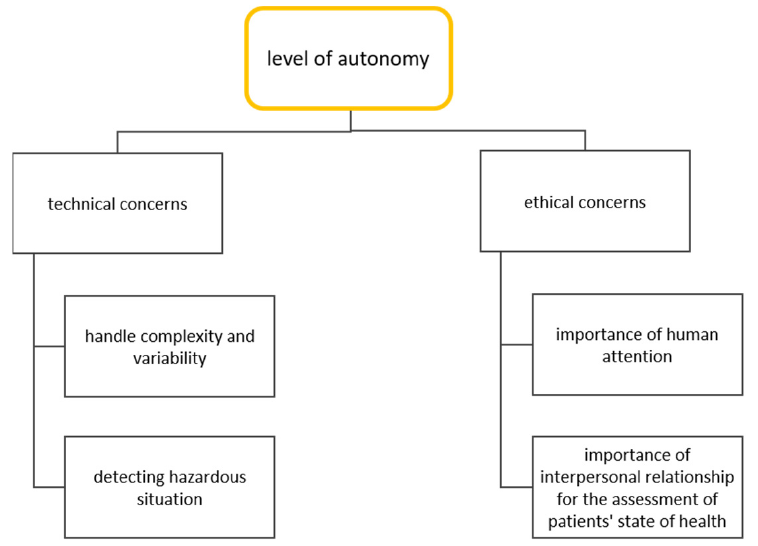
Figure 5. Overview of the technical and ethical concerns related to the automation of care activities as well as the level of robot autonomy.